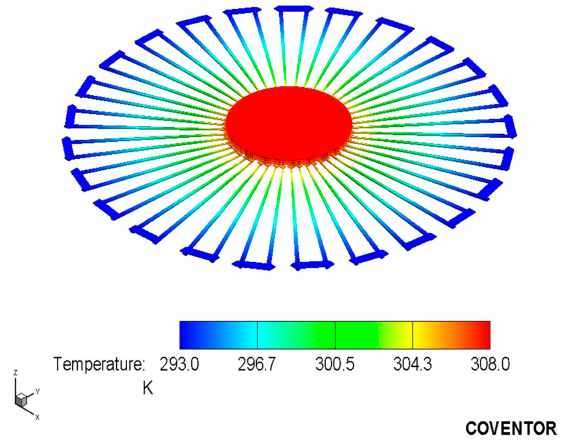
Figure 2. Simulated temperature distribution for the thermoelectric energy harvester.